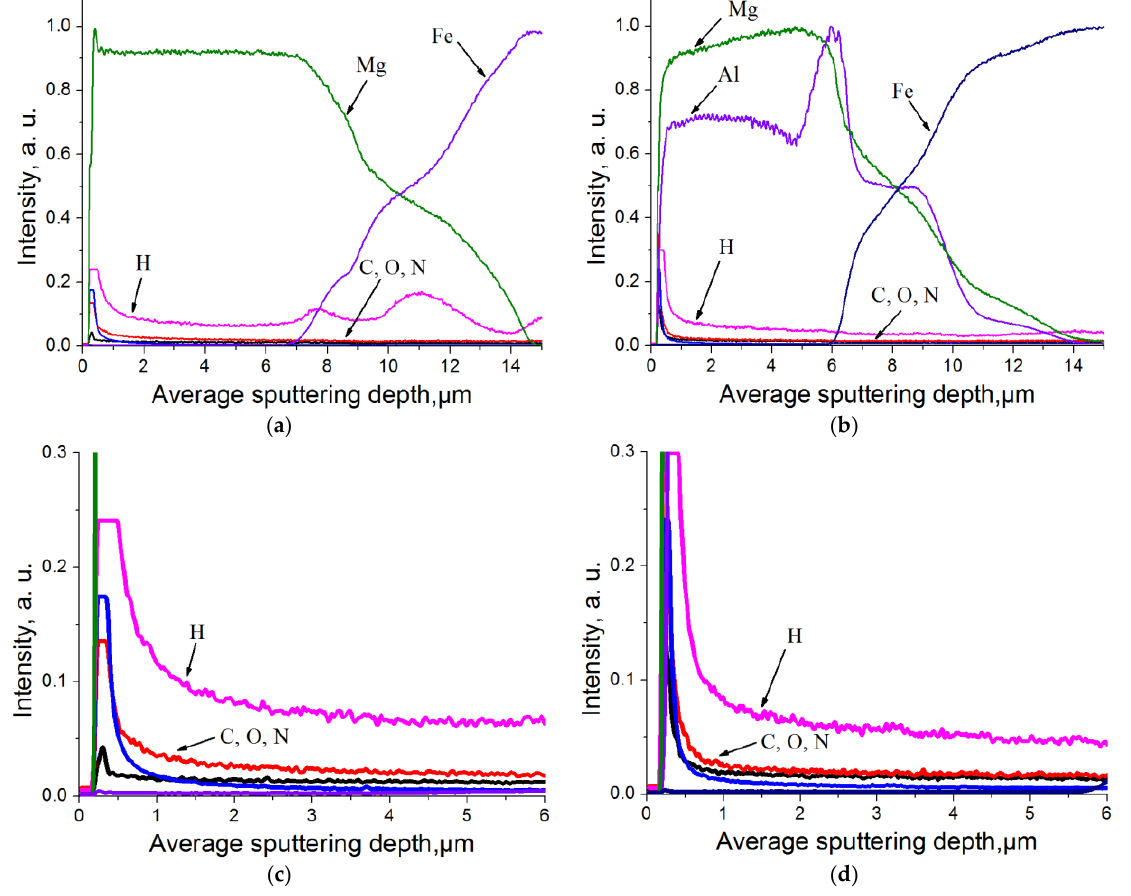
Figure 7. Depth distribution of chemical elements for samples with ( a ) Mg coating; ( b ) Mg-10%Al coating after hydrogenation during 10 h and 30 atm. The figures ( c , d ) represent the hydrogen distribution in the coatings in more detail.